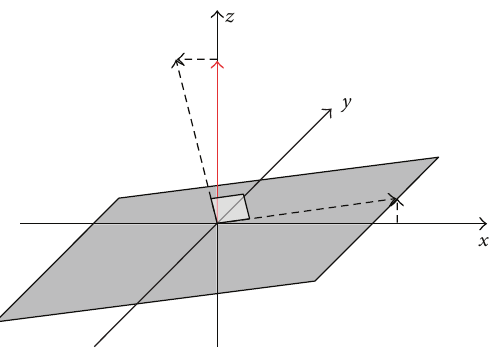
Figure 13: The setup of the topography of CE-1 elevation map.